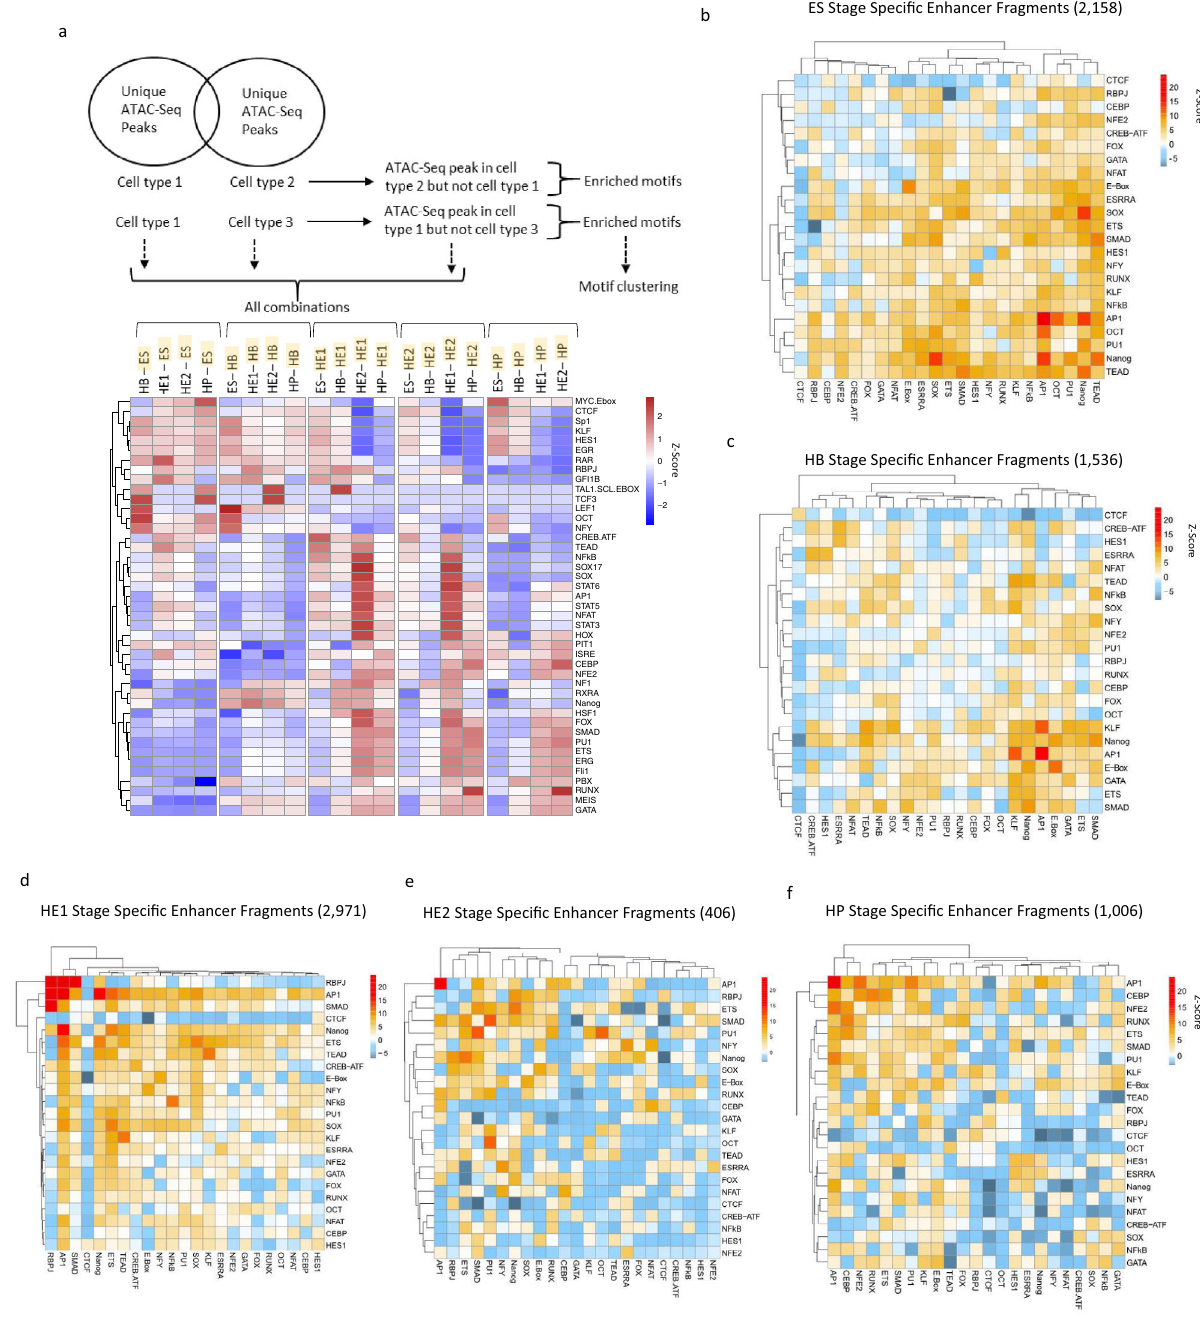
Fig.3|Stage-speci fi cenhancerelementsshowaspeci fi cTFmotifandmotifco- localization pattern. a Identi fi cation of speci fi c TF binding motifs in cell type speci fi c open chromatin regions (distal elements only) as described in ref. 18 . The upper panel shows the fi ltering strategy. The lower panel shows how speci fi c binding motifs are enriched in ATAC-Sites that are speci fi c for each cell type (highlighted in yellow) as compared to another cell type (indicated by brackets). b – f Motif co-localization analysis. Heatmaps depicting Z-Score enrichments for pairs of TF binding motifs within 50bp for fi ve cell differentiation stages as indi- cated on top of each heat-map, together with the number of fragments